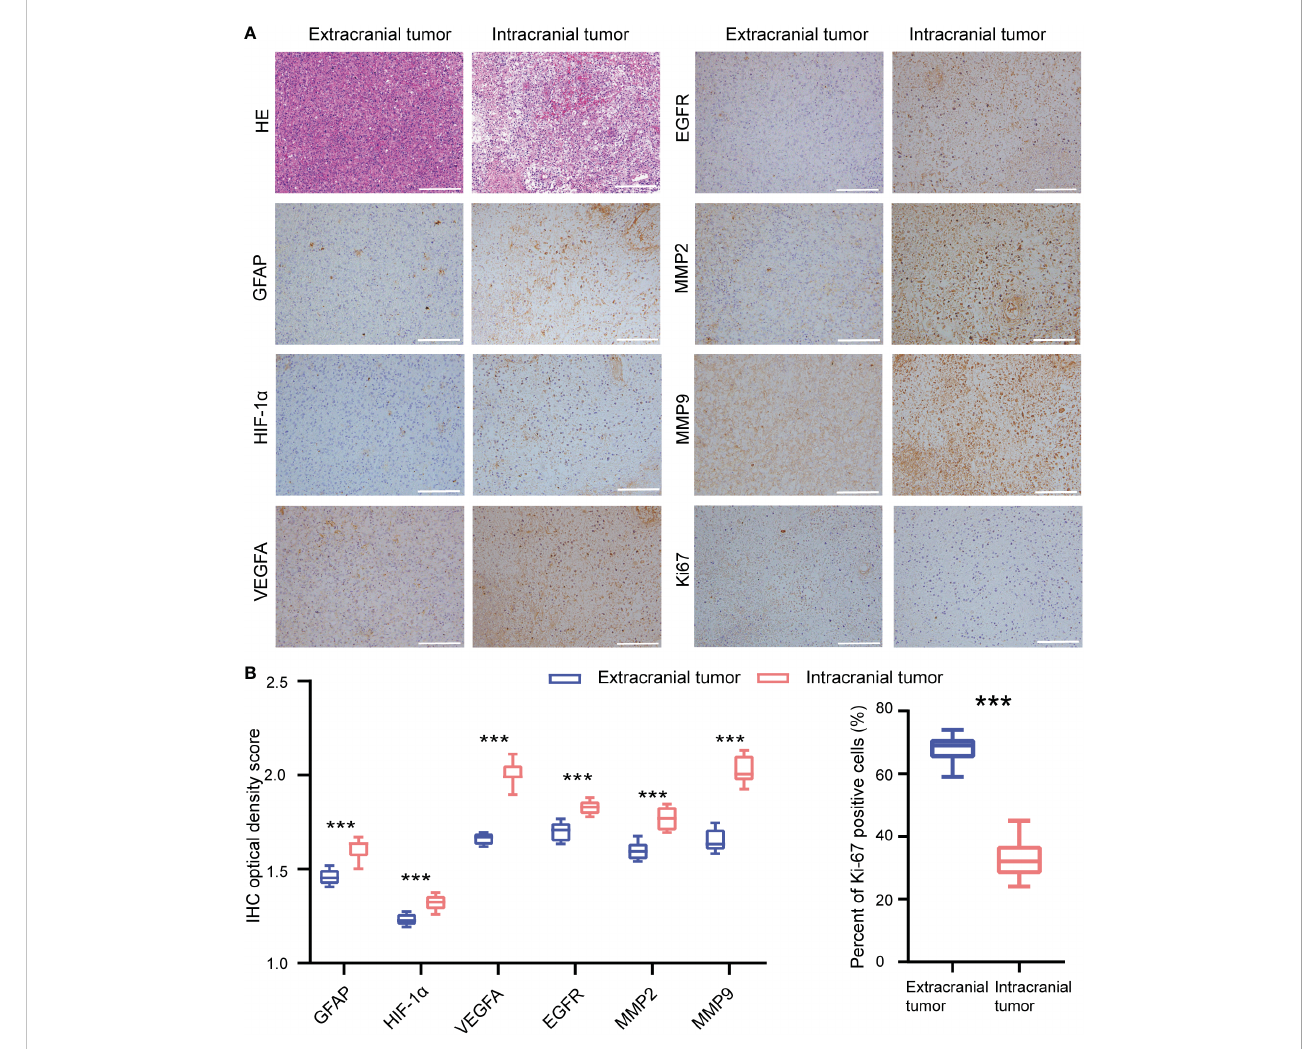
FIGURE 2 Immunohistochemistry analysis of the extracranial tumor and intracranial tumor. (A) Representative immunohistochemical images of extracranial tumor and intracranial tumor in patient. (B) Quanti fi cation of the immunohistochemical stains. Scale bar = 200 m m. *** p